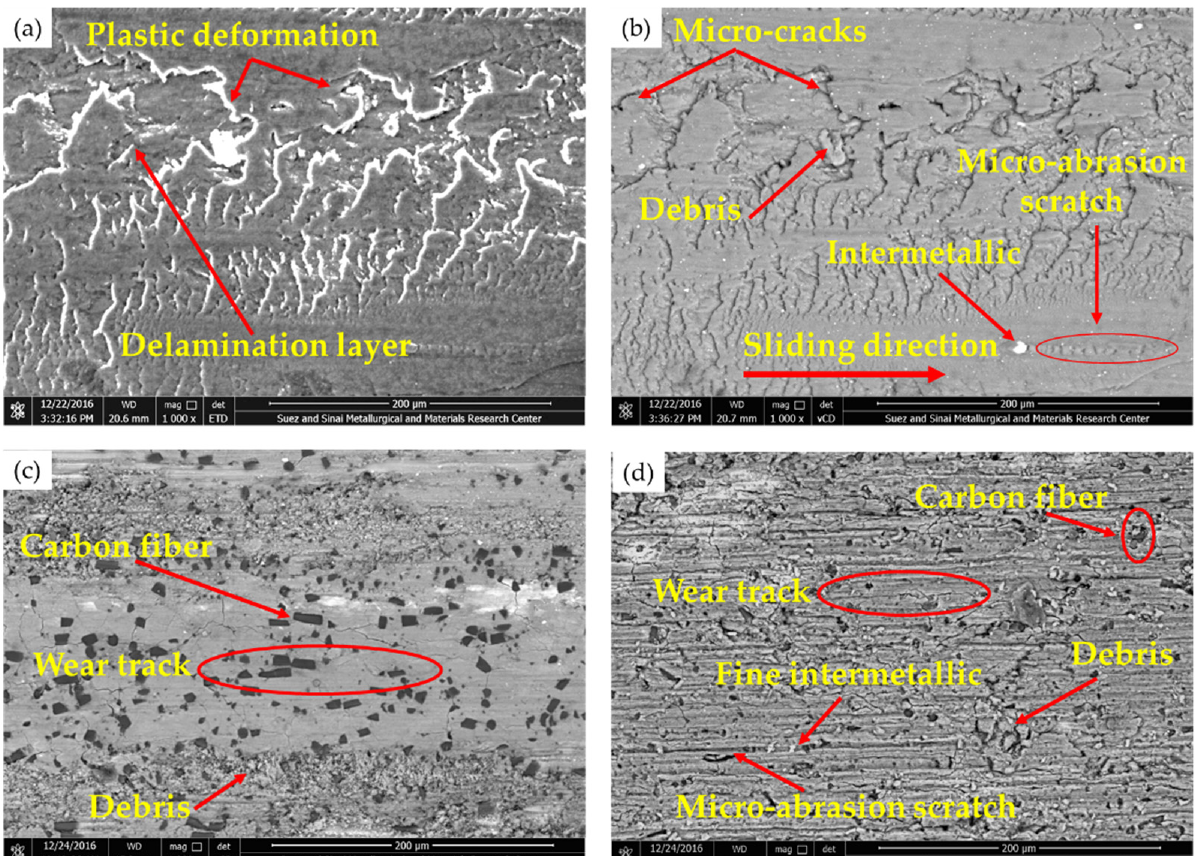
Figure 8. SEM images of the worn surfaces of the wear-tested specimens, where ( a , b ) AZ91-BM in ETD and vCD modes, respectively, ( c ) Composite-N and ( d ) Composite-P at the wear test conditions of wear load of 2 N and sliding distance of 1.34 × 10 (cid:2872) m.